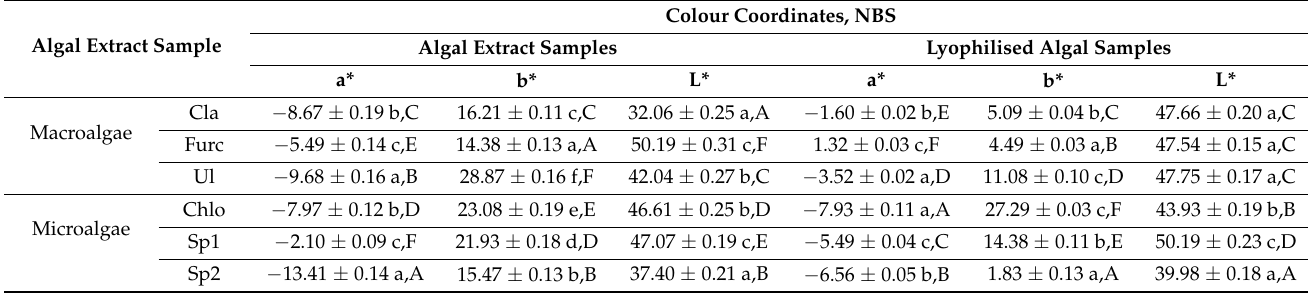
Cla, Cladophora rupestris ; Ul, Ulva intestinalis ; Furc, Furcellaria lumbricalis ; Chlo, Chlorella vulgaris ; Sp1, Spirulina ( Arthrospira platensis ) multiplied in the laboratory; Sp2, Spirulina (Ltd. “Spila“); L*, lightness; a*, redness or − a*, greenness; b*, yellowness or − b*, blueness; NBS, National Bureau of Standards units; data are represented as means (n = 3, replicates of analysis) ± SD. a–f for the same analytical parameters, in macro- and microalgae groups, means with different letters are significantly different ( p ≤ 0.05). A–F for the same analytical parameters, in all algal samples, means with different letters are significantly different ( p ≤